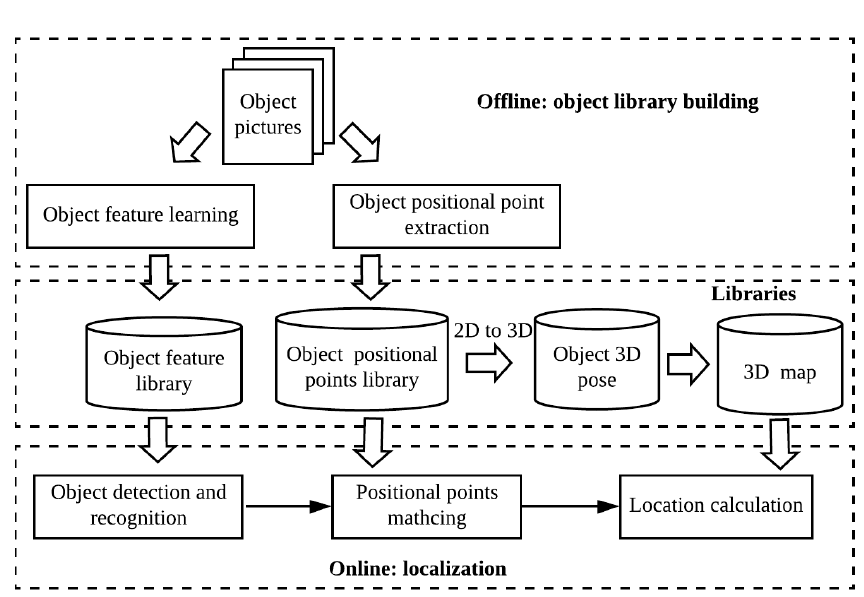
Figure 3. Pictorial Planner Object Based VBL